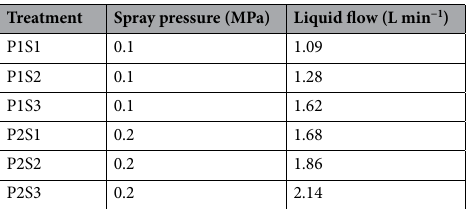
vars were chosen with different leaf surface characteristics. Jia58 with upright leaves, smooth and hairless and Yongyou12 with upright leaves and hairy leaves were used in the experiment 14 , which were obtained from the